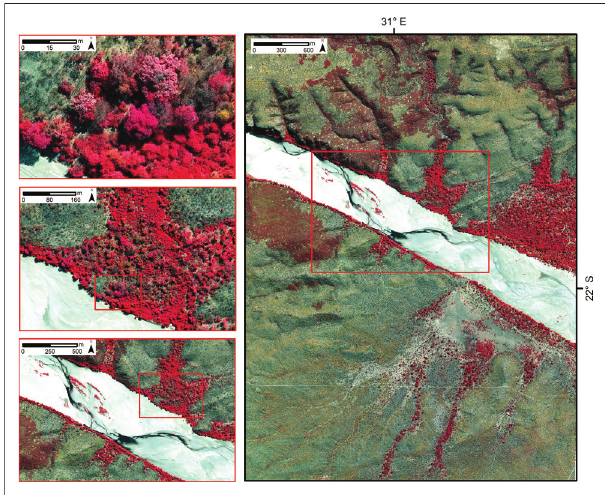
FIGURE 6: Orthorectified colour-infrared aerial imagery at different scales enabling local to regional analysis; single bushes and trees can easily be delineated.